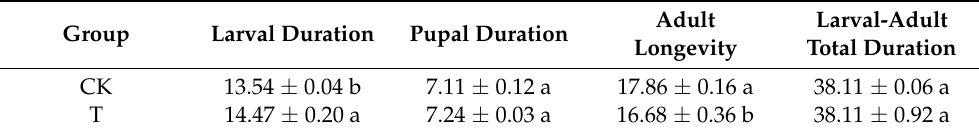
Table 5. Development duration of Grapholita molesta after antibiotic feeding. Group Larval Duration